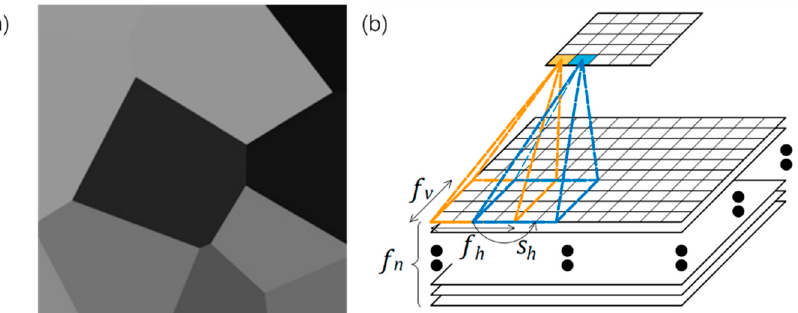
Figure 12. ( a ) morphologies of statistical volume elements ( b ) schematic of the receptive field of a convolutional layer [115]